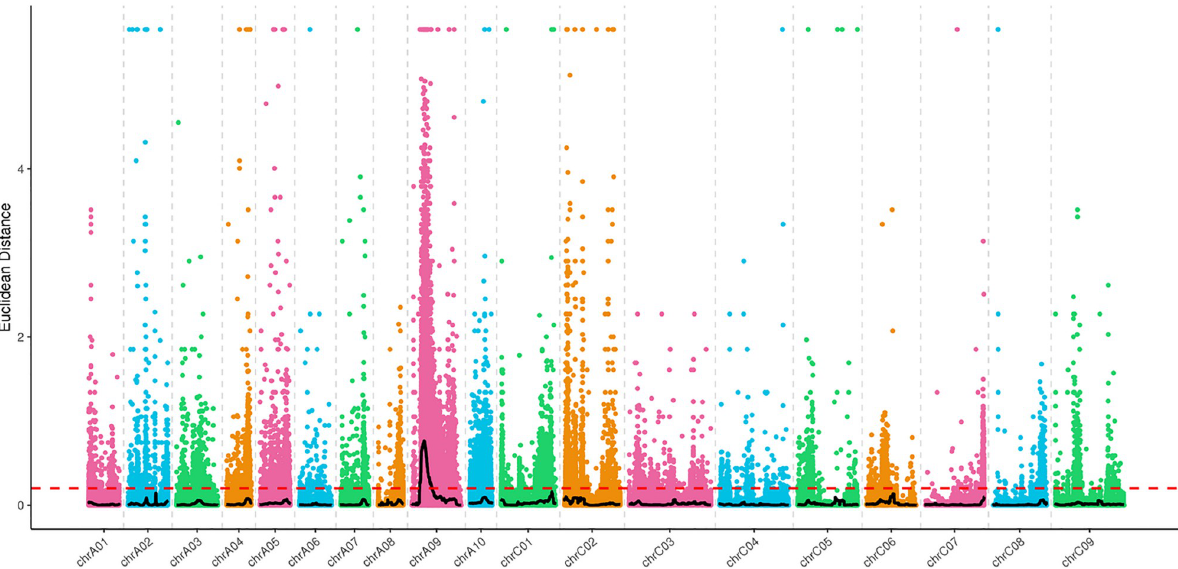
Fig 4. Distribution of Euclidean Distance (ED) association values on chromosomes. The abscissa is the chromosome name, the colored dots represent the ED values of each SNP site, the black line represents the fitted ED value, and the red dotted line represents the significant association threshold. The higher the ED value is, the greater association of the point, and the stronger the